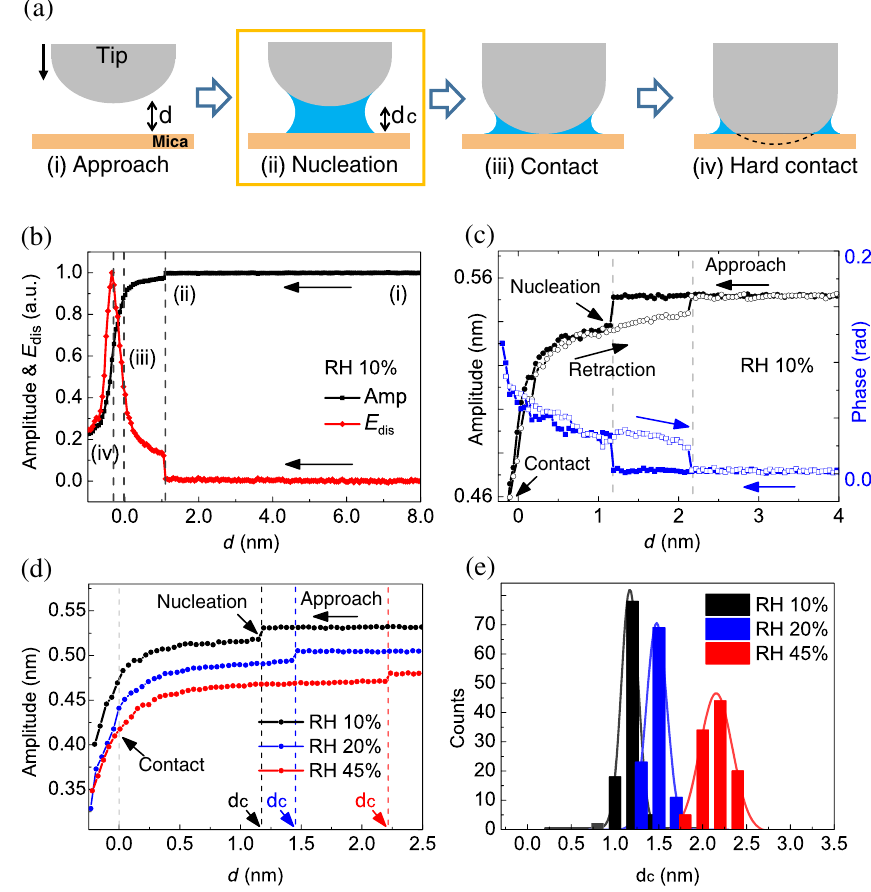
FIG. 2. (a) Schematic of determining d and the contact point during tip approach. (b) Change of oscillation amplitude and energy c dissipation in arbitrary units during the full approach until hard contact. The specific points (i) – (iv) correspond to each step in (a). (c) Typical approach-retraction curve at 10% RH. Filled black (blue) dots represent the amplitude (phase) change during approach, while the open black (blue) dots show those obtained during retraction. (d) Approach curves versus RH. (e) Histogram plot of d 100-times approach-retraction curves. Here, d was measured as 1 . 2 (cid:2) 0 . 08 nm, 1 . 5 (cid:2) 0 . 1 nm and 2 . 2 (cid:2) 0 . 15 nm at RH of 10%, 20% c and 45%, respectively (here, the error denotes the standard